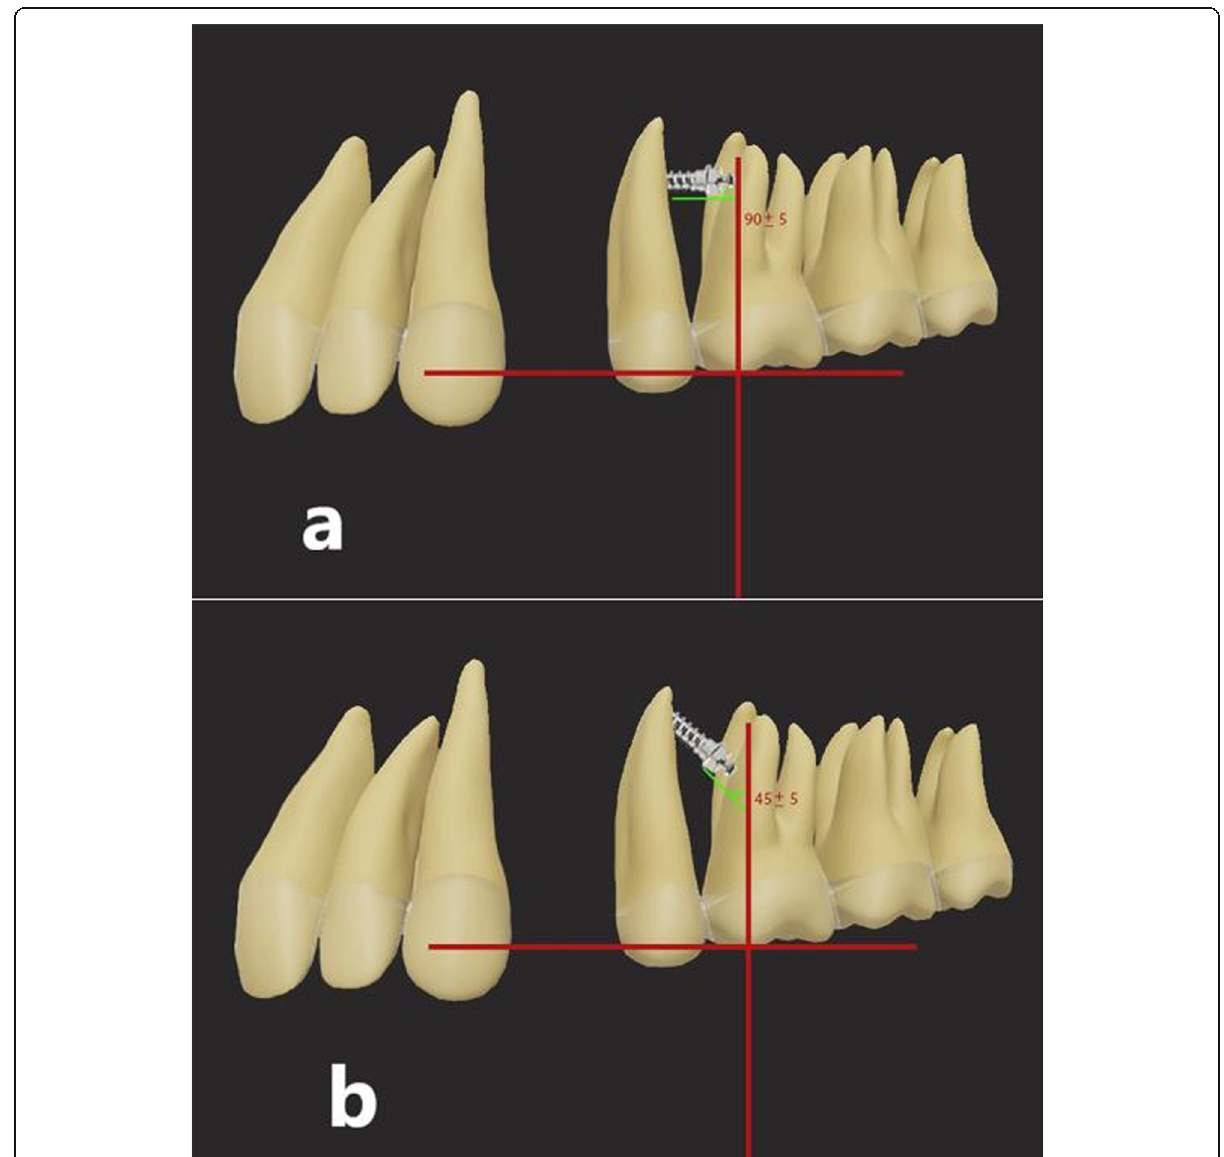
Fig. 1 Schematic view of the insertion of miniscrews: a 90° insertion angle, b 45° insertion